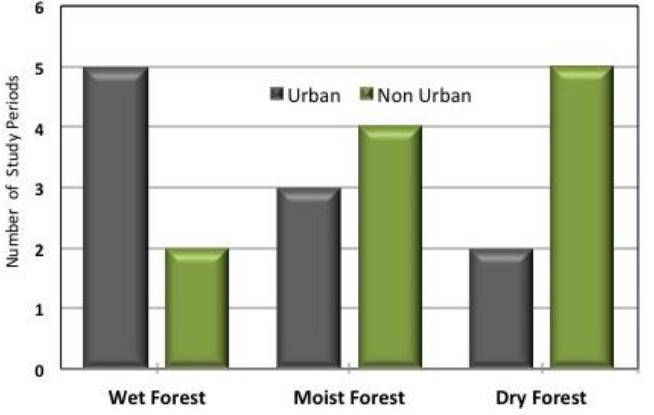
Figure 26. Number of study periods receiving higher yearly average urban vs. non-urban total